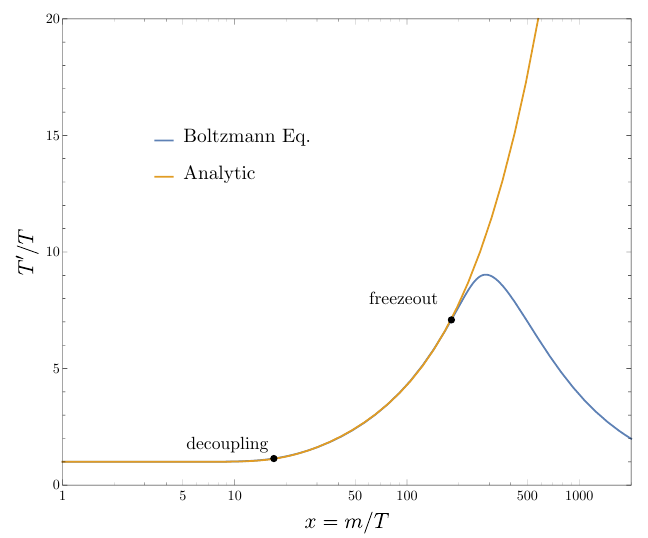
Figure 1 . Evolution of the ratio of ELDER temperature T 0 to the SM plasma temperature T